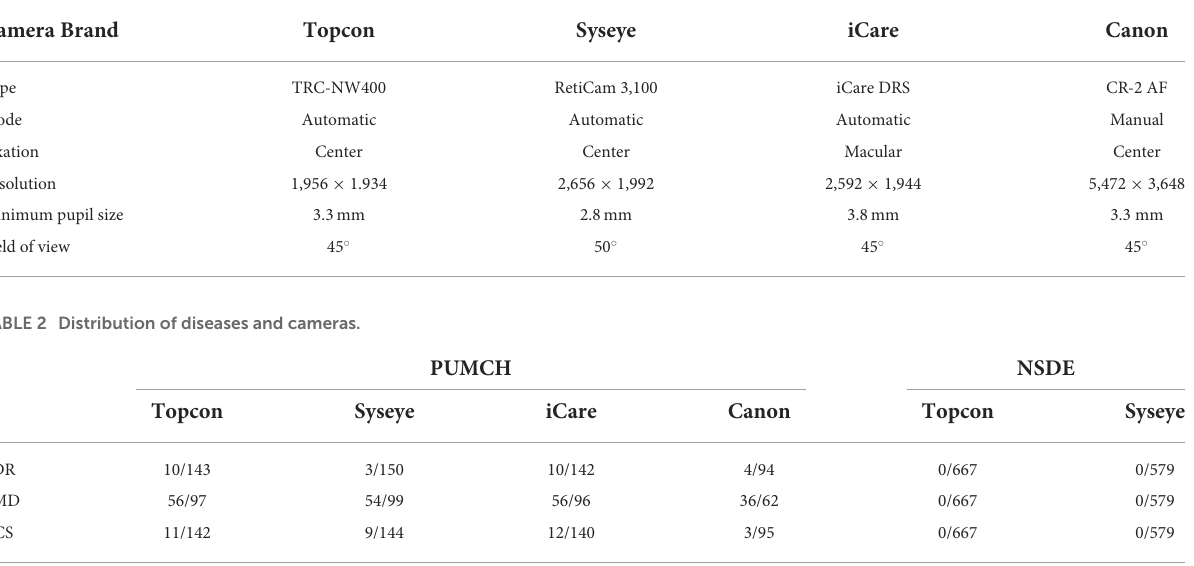
TABLE 1 Technical specifications of different cameras.